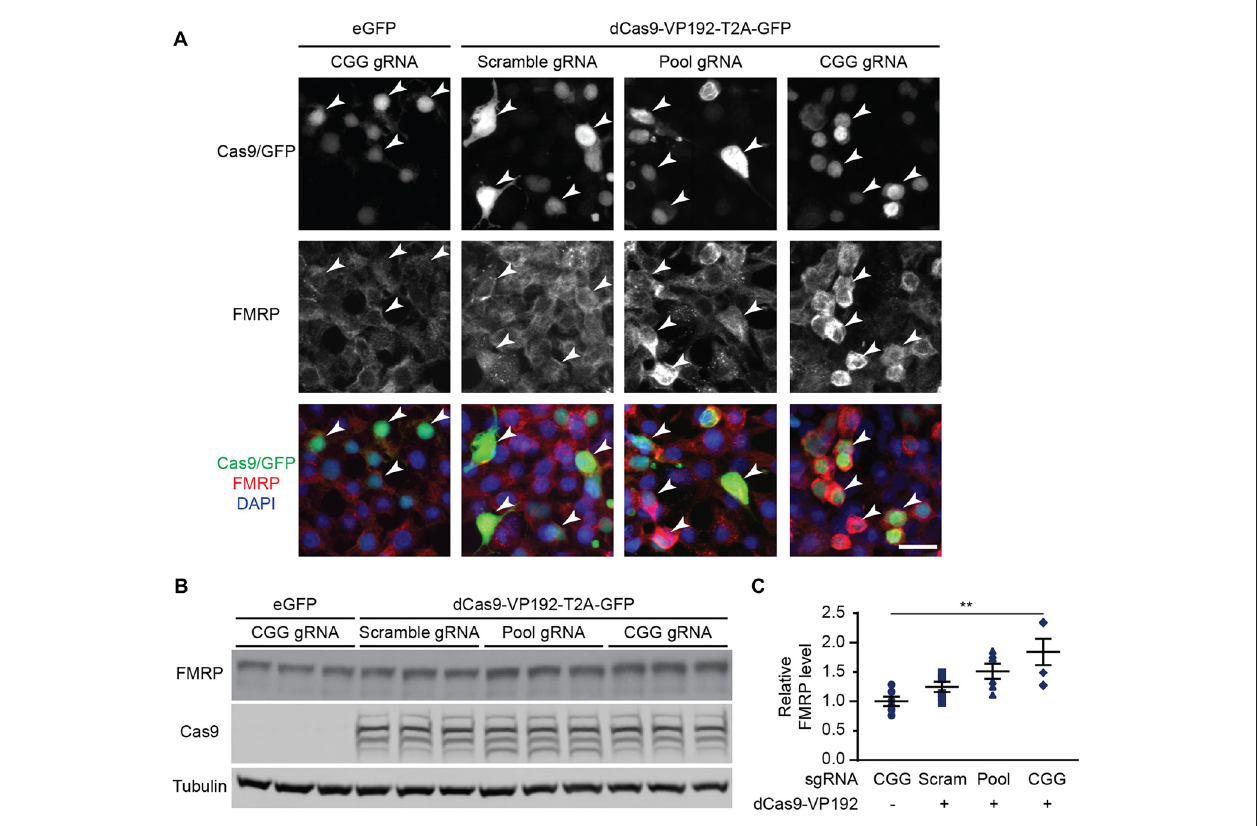
FIGURE 2 | CRISPR-mediated transcriptional activation increases FMRP protein abundance at normal CGG repeat sizes. (A) Immunocytochemistry of HEK293T cells transfected with eGFP or dCas9-VP192 and gRNAs, as indicated. Single channel and merged images are shown with Cas9/GFP (green), FMRP (red), and DAPI (blue). White arrowheads indicate transfected cells. Scale bar represents 20 µ m. (B) Western blots showing triplicate samples of HEK293T cells transfected with control plasmid (eGFP) or with dCas9-VP192 and indicated gRNAs and immunoblotted for FMRP, Cas9 and Tubulin. (C) Quantification of western blots from HEK293T cells transfected as indicated. Data are shown as FMRP normalized to tubulin and relative to the control plasmid ( n = 6/group evaluated over at least two independent experiments. ∗∗ p < 0.01, Kruskal-Wallis one-way ANOVA with Dunn’s multiple comparison test). Error bars represent